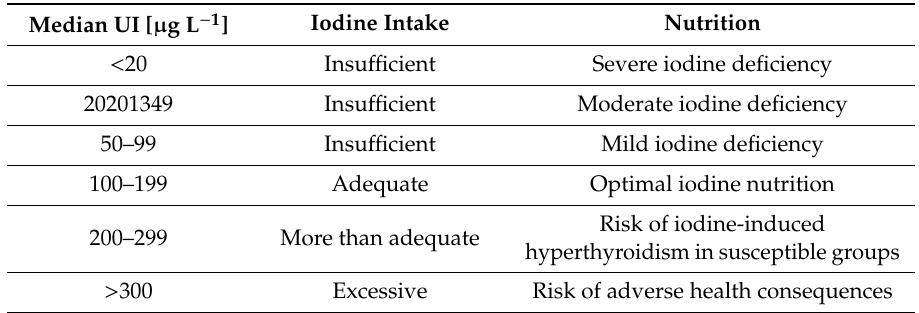
Table 2. Criteria for assessing adequate daily iodine intake based on median urinary iodine (UI) concentrations in school-age children [13].